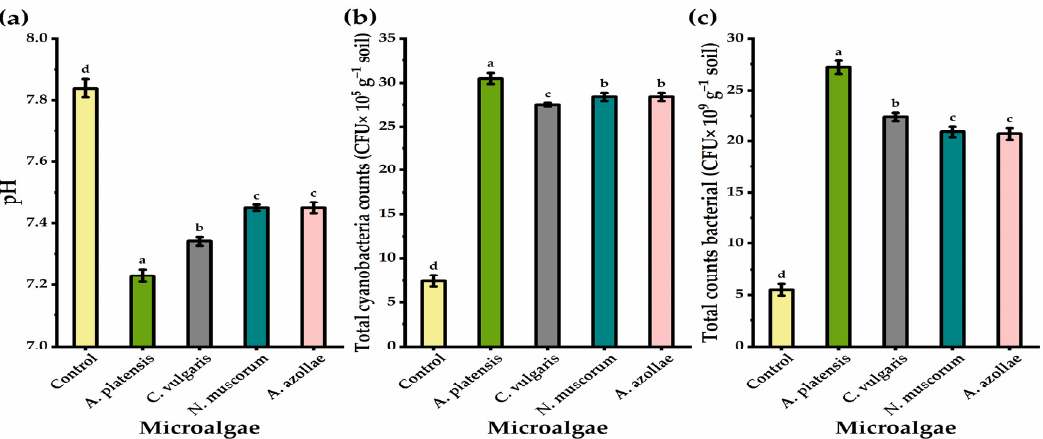
Figure 2. pH ( a ), total cyanobacteria ( b ), and total bacterial count ( c ) of soil cultivated by chia plants under alkaline stress conditions in response to soil drenching application method with microalgae treatments. The bars with different letters are significantly different at p ≤ 0.05 by DMRT.